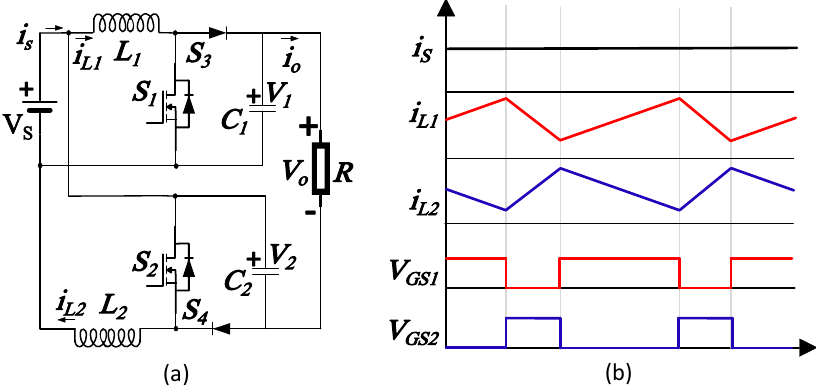
Figure 2. Two-phase FIBC when 𝐷 (cid:2869) = 0.7 and 𝐷 (cid:2870) = 0.3: ( a ) schematic diagram; ( b ) relevant wave- forms.